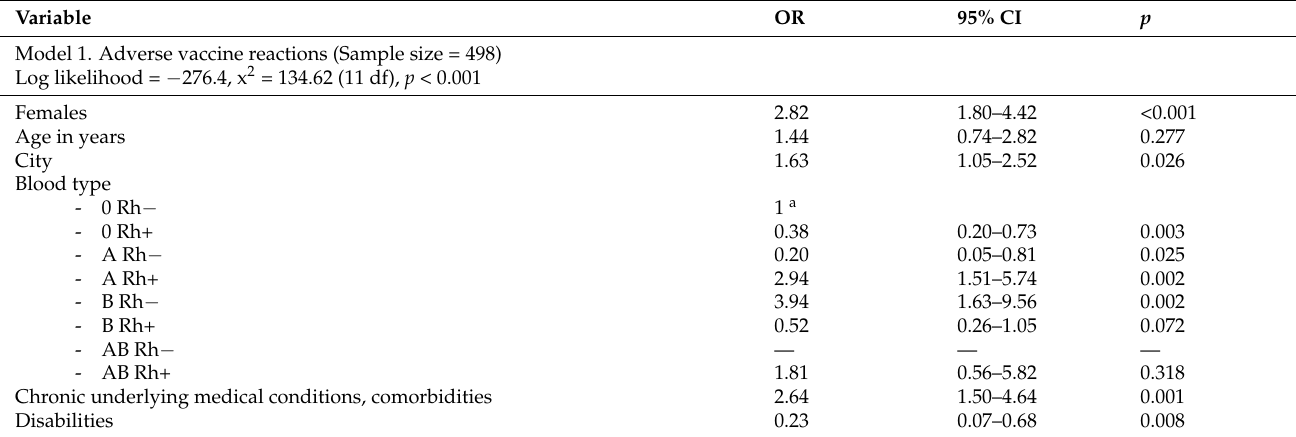
Figure 2. Difference in health perception after the first and second doses of Vaxzevria on the outcome of males and females. Table 2. Results of multivariate logistic regression analysis examining outcomes of interest based on several explanatory variables .